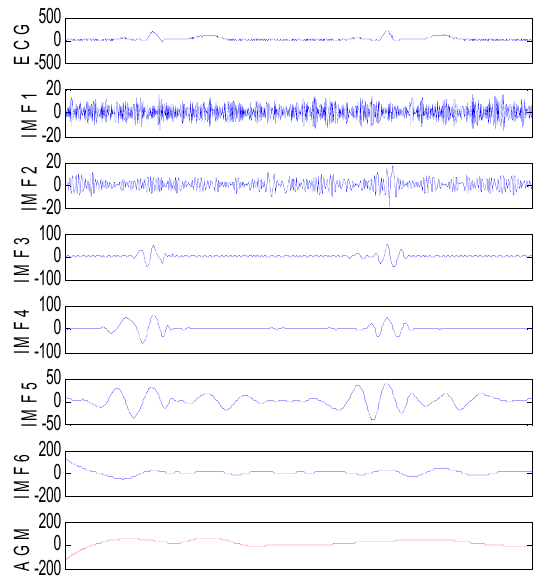
Figure 1. The ESMD method based decomposition of the noisy ECG signal corrupted by Gaussian noise with the variance of 60.